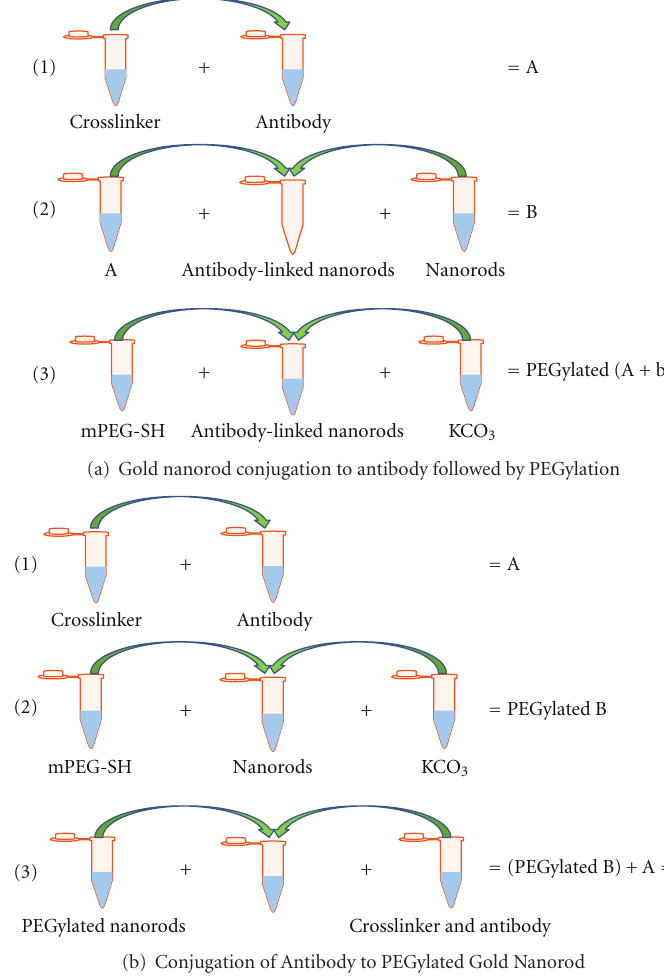
Figure 1: Illustration of Nanorod to Antibody Conjugation. (a) Gold nanorod conjugation to antibody followed by PEGylation and (b) conjugation of antibody to PEGylated